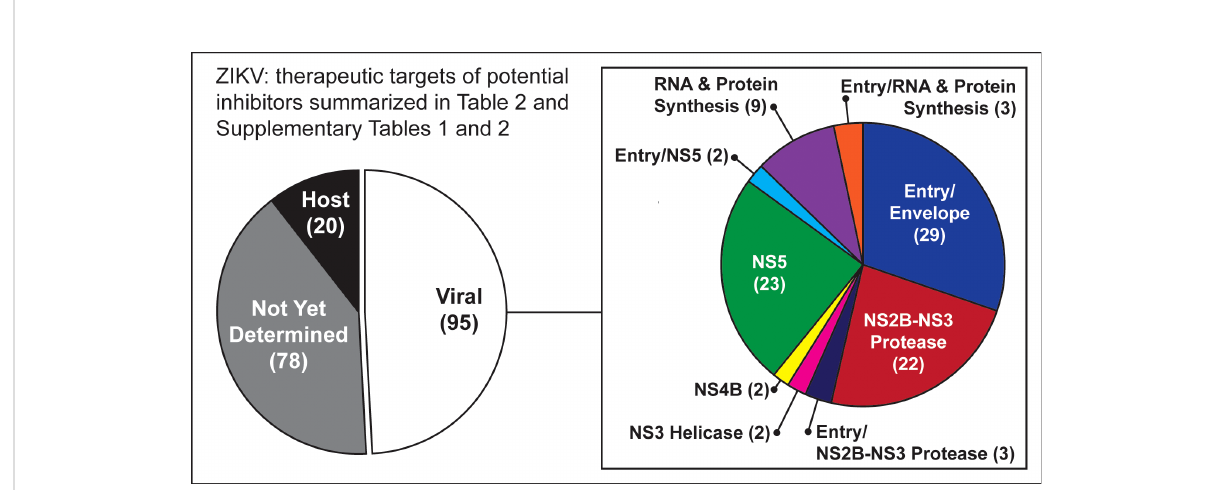
FIGURE 2 Graphic summary of targets for potential inhibitors listed in Table 2 and Supplementary Tables 1, 2. The most common viral protein targets for those inhibitors are NS2B-NS3 protease, NS5, and E or other entry-related